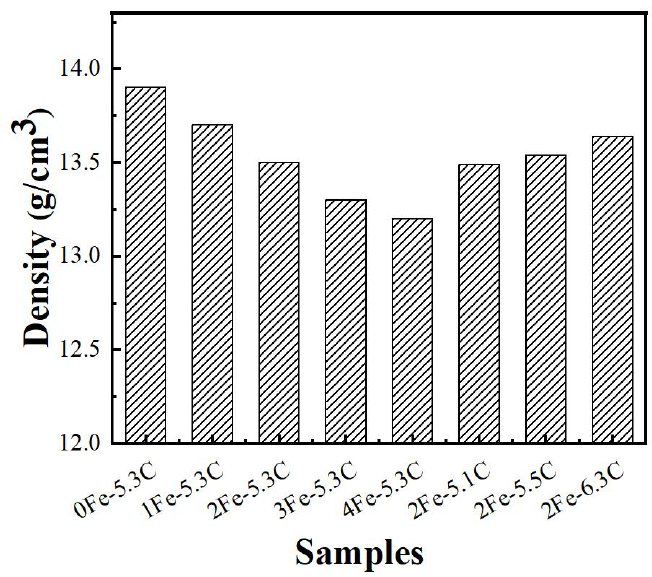
Figure 10. The effects of addition of Fe and C on the densities of WC–13 (Co–Fe) composites.